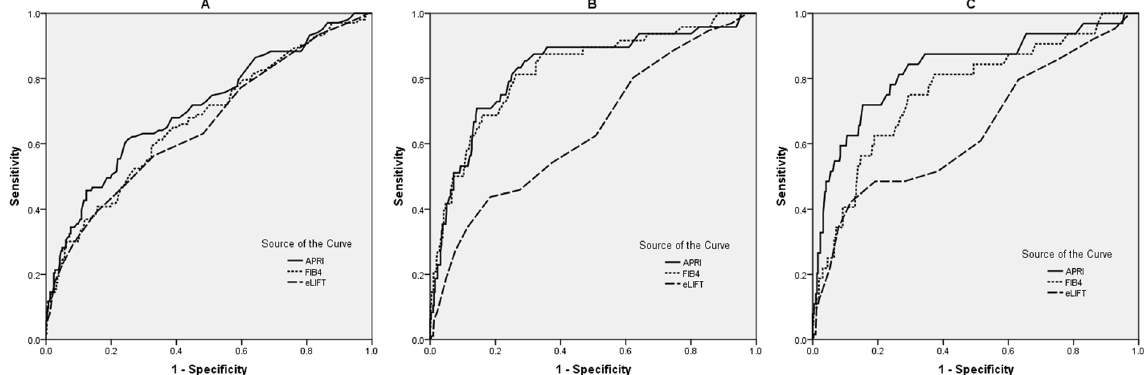
Figure 3. ROC curves for significant fibrosis ( A ), severe fibrosis ( B ), and cirrhosis ( C ) APRI, aspartate transaminase to platelet ratio index; FIB-4, fibrosis index based on the 4 factors; eLIFT, the easy Liver Fibrosis Test; The AUROC of eLIFT was comparable with that of APRI and FIB-4 to predict advanced fibrosis ( p > 0.05), but lower than that of APRI and FIB-4 to predict severe fibrosis and cirrhosis ( p < 0.05).